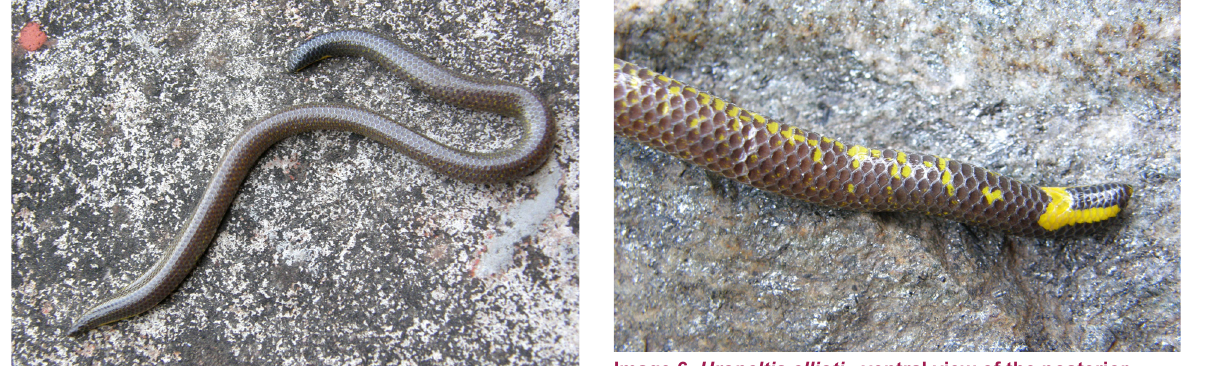
Image 6. Uropeltis ellioti - ventral view of the posterior